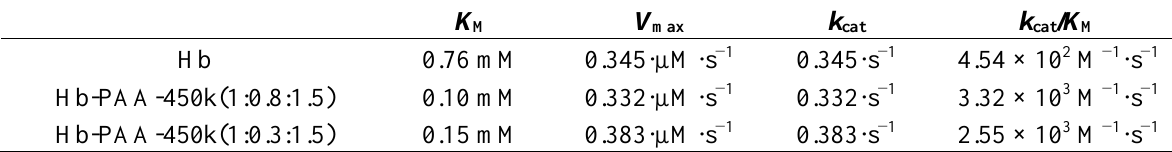
Table 1. K M , V max , k cat and k cat / K M values for Hb, Hb-PAA-450k(1:0.8:1.5) and Hb-PAA-450k (1:0.3:1.5) samples. V max values of Hb-PAA conjugates are comparable to Hb and K m